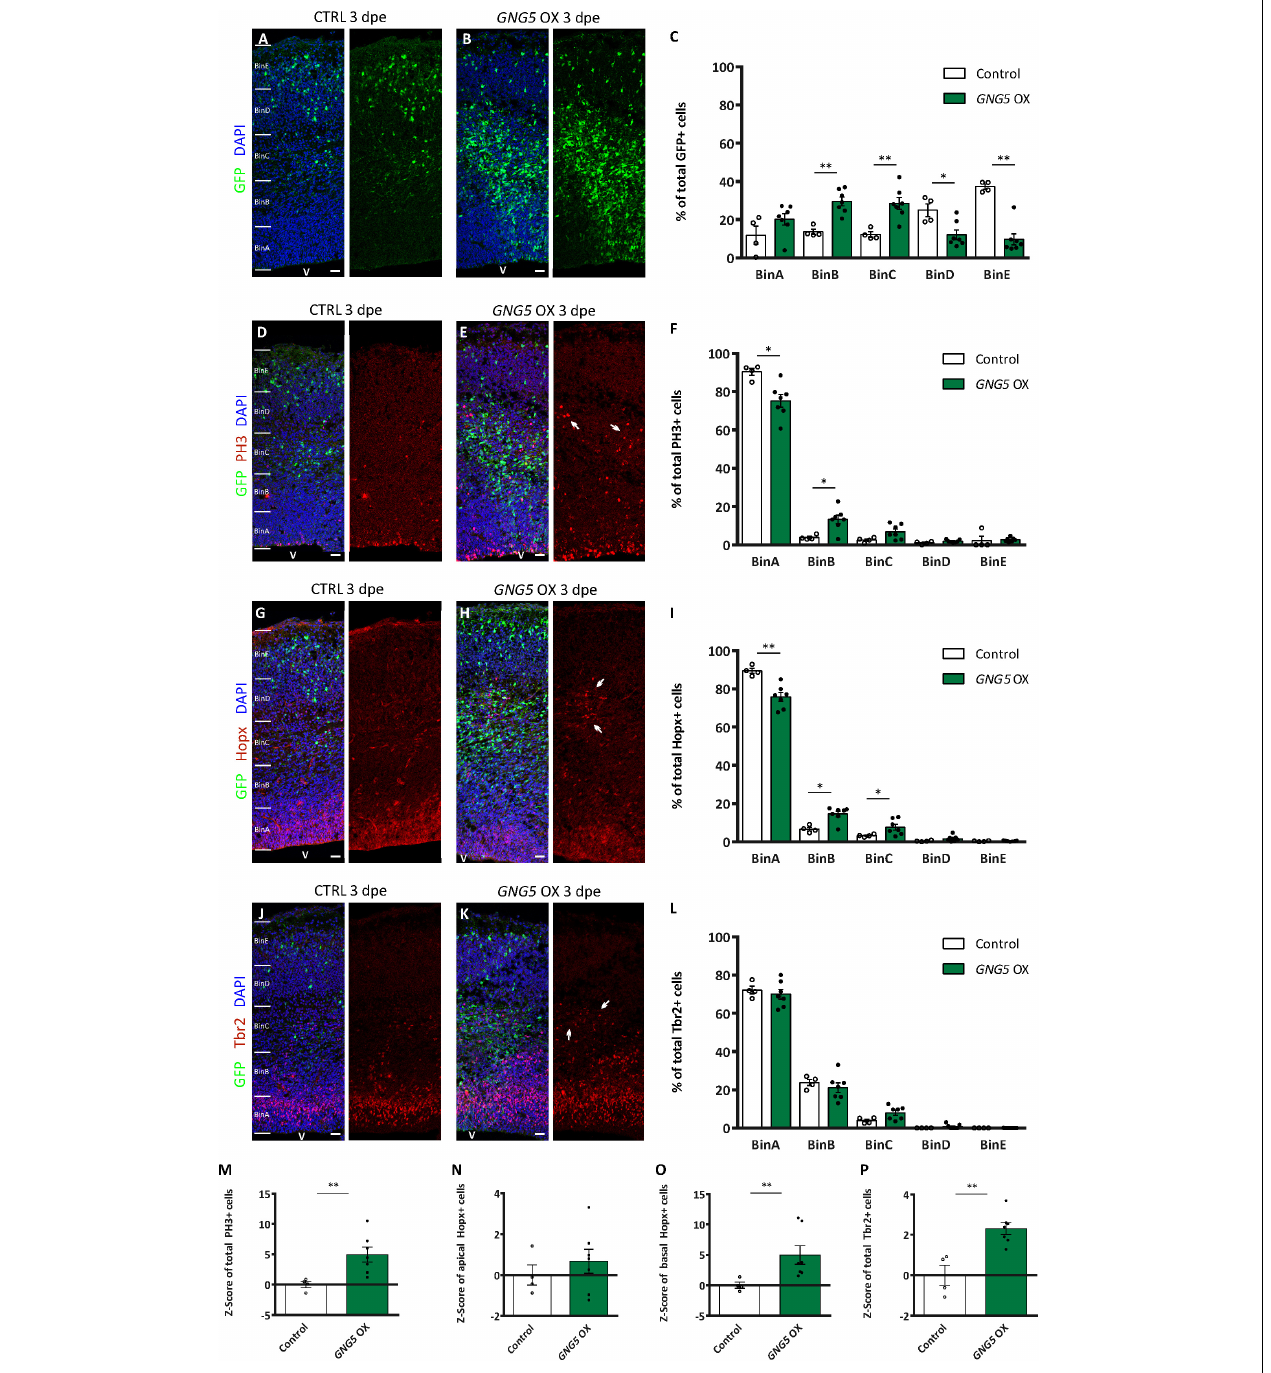
FIGURE 4 | Acute overexpression of GNG5 in mouse embryos at E13 alters the proportion of progenitors three days post electroporation. (A,B) Representative pictures of electroporated mouse brain sections stained for GFP and (C) distribution of GFP+ cells per bin. Sections were divided into five equal bins. In embryos electroporated with the control plasmid, GFP+ cells are distributed in all the bins while in GNG5 OX mice, GFP+ cells can be found mainly in BinB and BinC. (D,E) Representative pictures of sections stained with PH3 and (F) distribution of PH3+ cells per bin. There is an increased amount of PH3 in GNG5 OX in upper bins indicated by arrows. (G,H) Representative images of sections stained with Hopx and (I) distribution of Hopx+ cells per bin. In GNG5 OX, there is an increased amount of Hopx+ cells in higher bins. Arrows indicate a cluster of Hopx+ cells. (J,K) Representative pictures of sections stained with Tbr2 and (L) distribution of Tbr2+ cells per bin. In GNG5 OX, there is a general increase of Tbr2+ cells indicated with the arrows. The total number of cells per section are shown as Z-scores: (M) PH3+, (N) apical Hopx+, (O) basal Hopx+ and (P) Tbr2+. Statistical significance was based on Mann-Whitney test ∗ p < 0.05 and ∗∗ p < 0.01. Control n = 4 and GNG5 OX n = 7. Data are represented as mean ± SEM. Scale bar: 30 µ m. Abbreviations: CTRL, control; OX, overexpression; V,